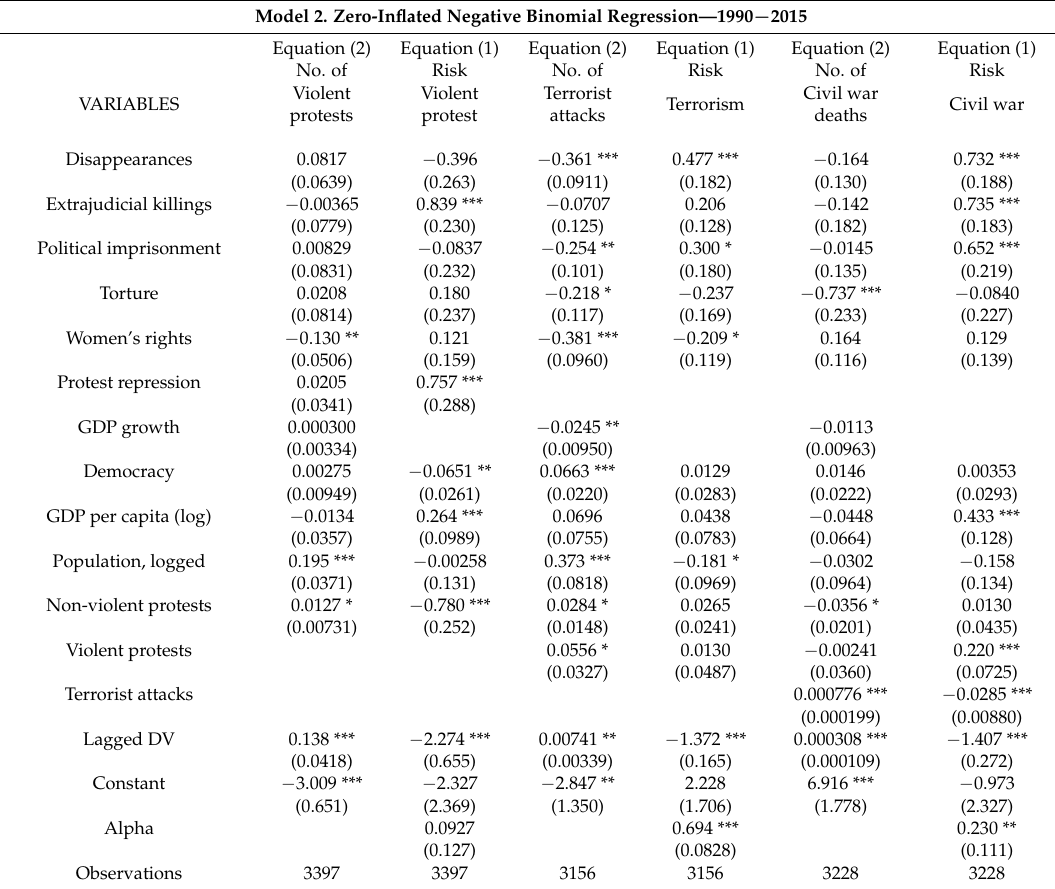
Table A4. Types of Physical Integrity Rights, Women’s Rights and Internal Conflict, Full Table. Model 2. Zero-Inflated Negative Binomial Regression—1990 −